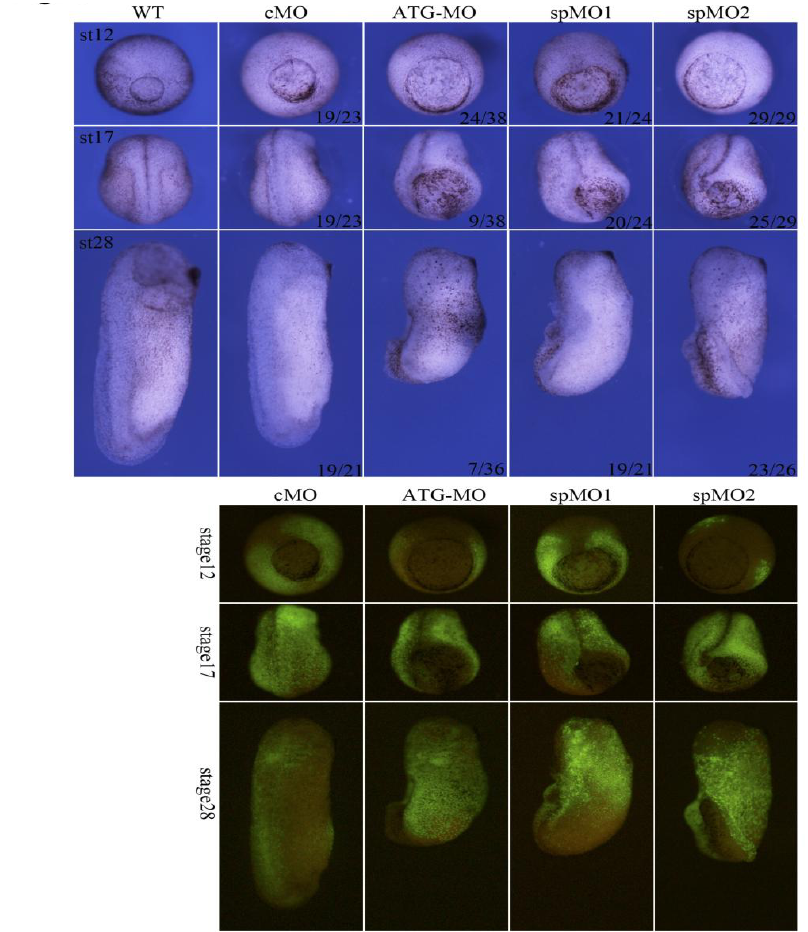
Figure 6. Knockdown of Hes5.9 resulted in defective embryo morphogenesis. 10 ng MO/embryo was ventrally injected at the 4-cell stage. Meanwhile, fluorescent dextran was co-injected as a lineage tracer. cMO means control MO, ATG-MO targeting translational start site, while spMO1 and spMO2 binding to splicing sites (more details about scheme and efficiency are shown in supplementary data Figure S3).